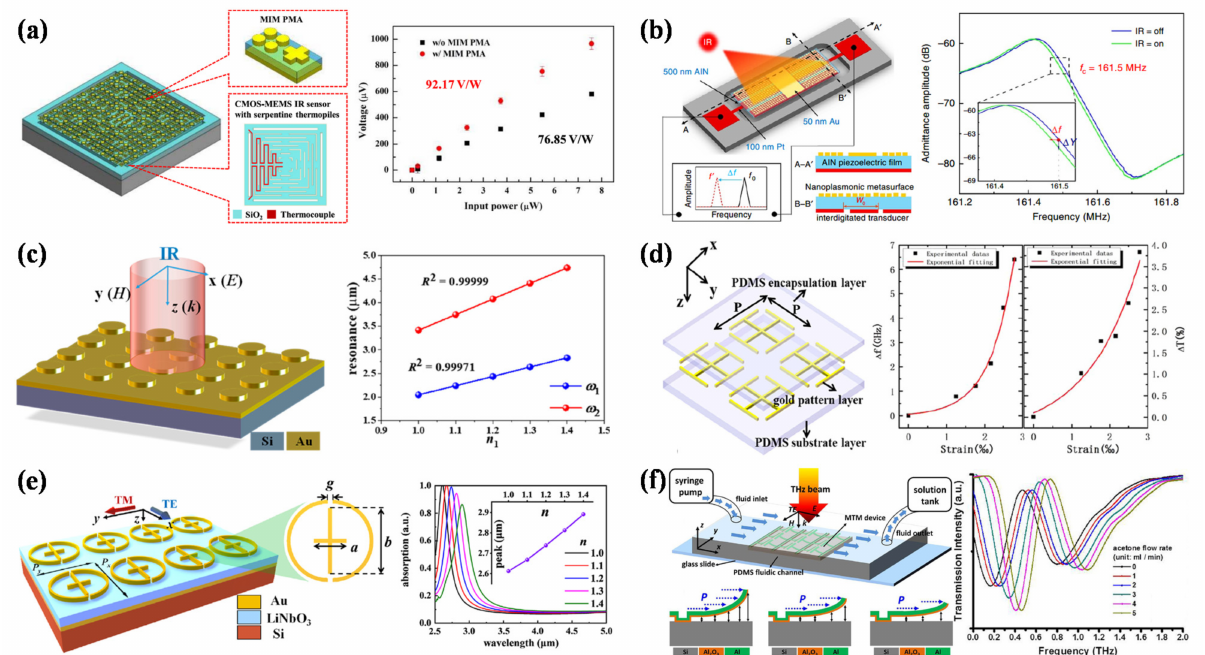
Figure 9. MEMS-based metamaterial for sensing applications. ( a ) Schematic of MEMS IR sensor integrated with MIM-based PMA [110]. The responsivity of IR sensors is determined from the measured output voltage and input power. ( b ) Schematic of plasmonic piezoelectric nanomechanical resonant IR detector [111]. Measured admittance curves versus frequency of the resonator for IR on and off states. ( c ) Schematic of SDM and the application for refraction index sensing [112]. ( d ) Schematic of the metamaterial strain sensor with a sandwich structure [113]. The relationship between frequency shift ( ∆ f ), amplitude modulation ( ∆ T ) and strain. ( e ) Schematic of tunable PMA and the application for refraction index sensing [114]. ( f ) Schematic of the MTM device integrated with a PDMS fluidic channel [76]. The initial, intermediate, and final state of an MTM cantilever with respect to low, medium, and high flow rates, respectively. The flow tuning characteristic of the MTM device under acetone